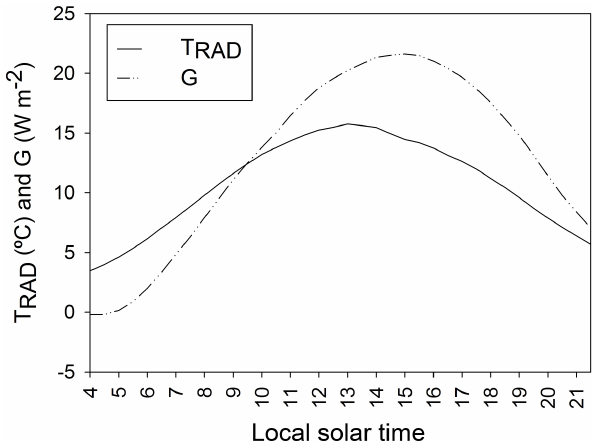
Figure 2. Mean daytime cycle for G and T RAD in the study area computed using all data available from the Fen, Tussock and Heath flux towers from 2008 to 2012.